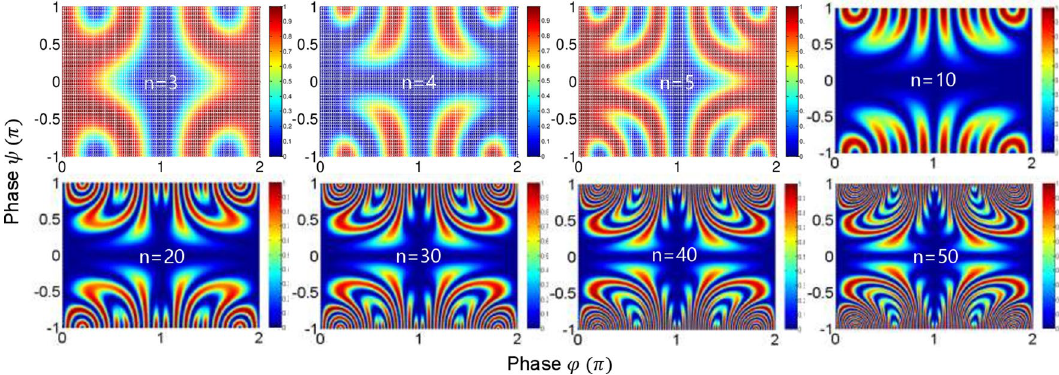
( n ) Figure 5. Numerical calculations for the output field intensity I β for different n in Fig. behaves as a perfect correlation system as shown by the dotted (solid) line in the lower right panel. If ψ = ± π , the coupled system swings between the quantum and classical bounds depending on ϕ -basis (discussed in Fig. 3). Figure 3 shows normalized intensity product R ij for Fig. 2. Figure 3a and b show the product R ij as functions of ϕ and ψ . Figure 3c and d are the details of Fig. 3a and b, respectively, where Fig. 3c represents the